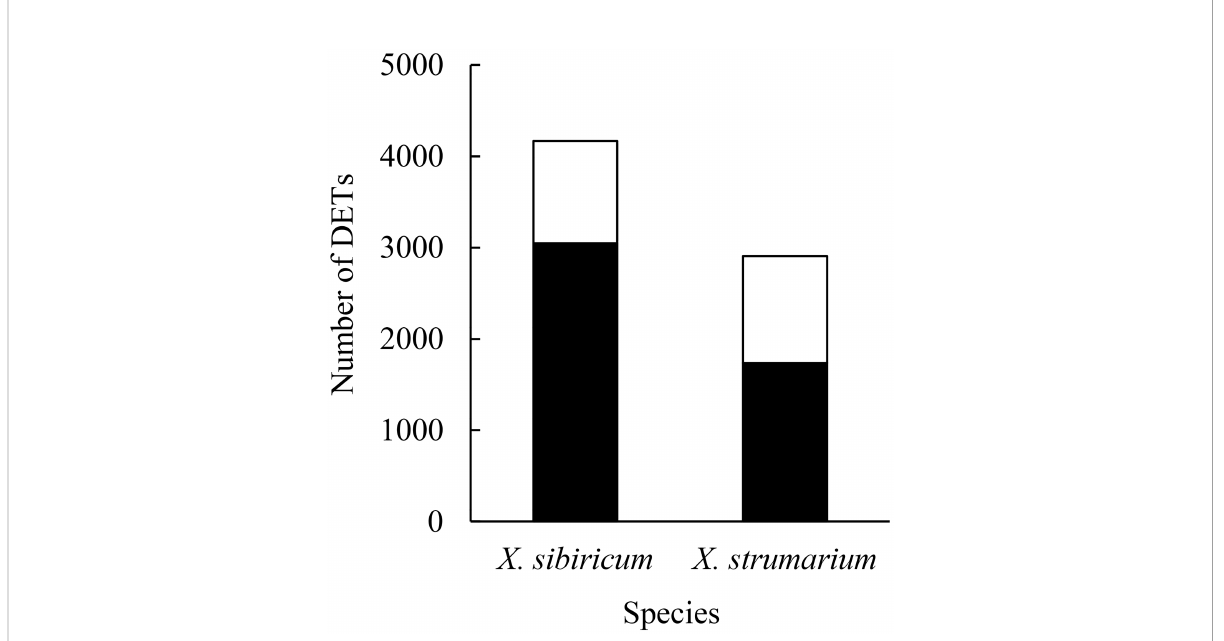
FIGURE 1 The numbers of differently expressed transcripts (DETs) between ammonium and nitrate treatments in Xanthium sibiricum and X. strumarium , respectively. Closed columns indicate the DETs induced by ammonium, i.e., expressed more highly under amonium relative to nitrate. Open columns indicate the DETs induced by